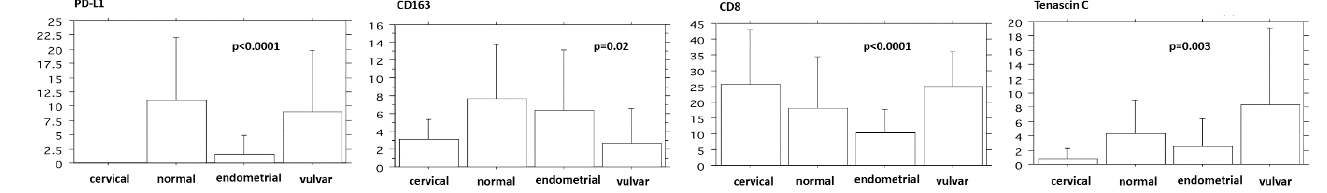
0.0222 Table 4. Comparison between regional cancer-draining lymph nodes and metastatic lymph nodes. Non-Metastatic Regional Lymph Nodes ( n = 63) <0.0001 Table 5. Comparison between non-cancer-draining lymph nodes and metastatic lymph nodes. Control Lymph Nodes ( n = 21)